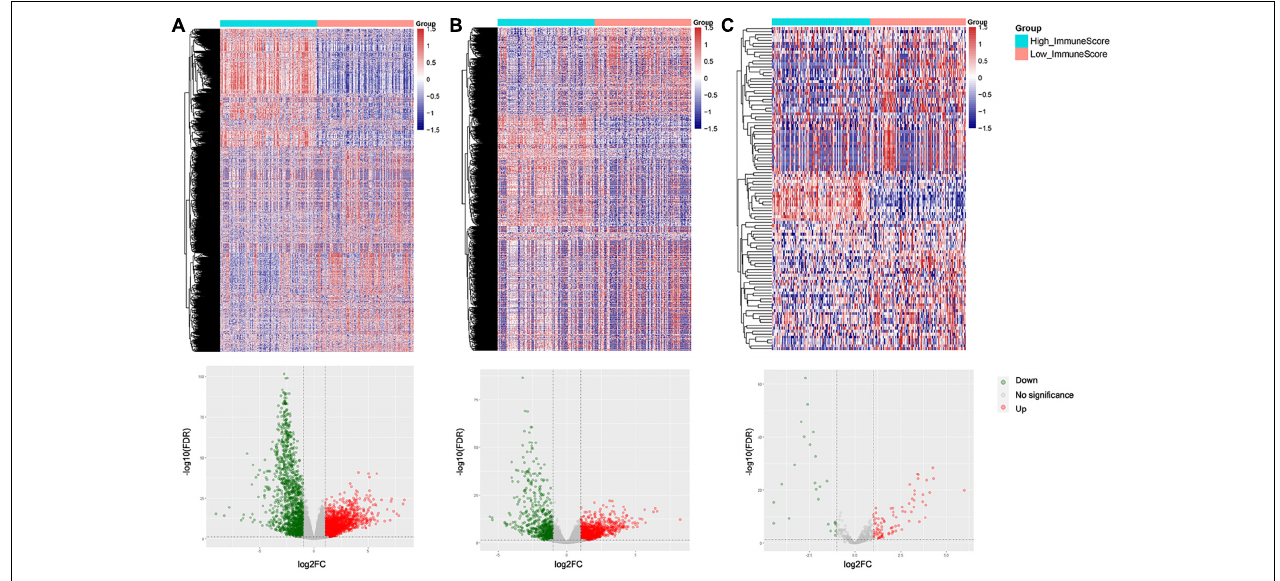
FIGURE 3 | Heatmaps and volcano plots of differentially expressed genes and miRNAs between the high and low immune score groups: (A) mRNAs, (B) lncRNAs, and (C) miRNAs.